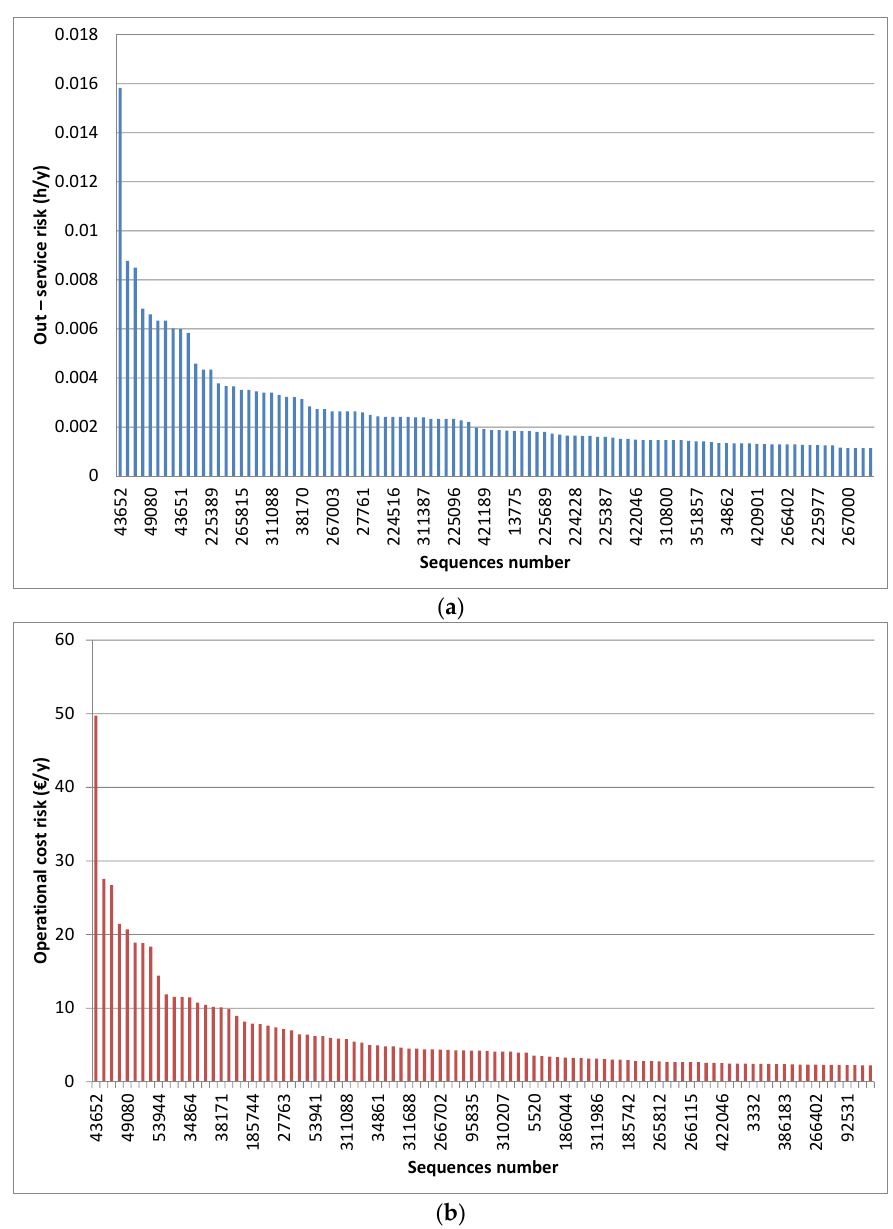
Figure 9. Details of the results bringing to high concentrations of VOCs in the output stream for the revers flow plant ( a ) The 100 sequences with the higher value of out ‐ service time risk; ( b ) The 100 sequences with the and higher value of risk of operational cost.